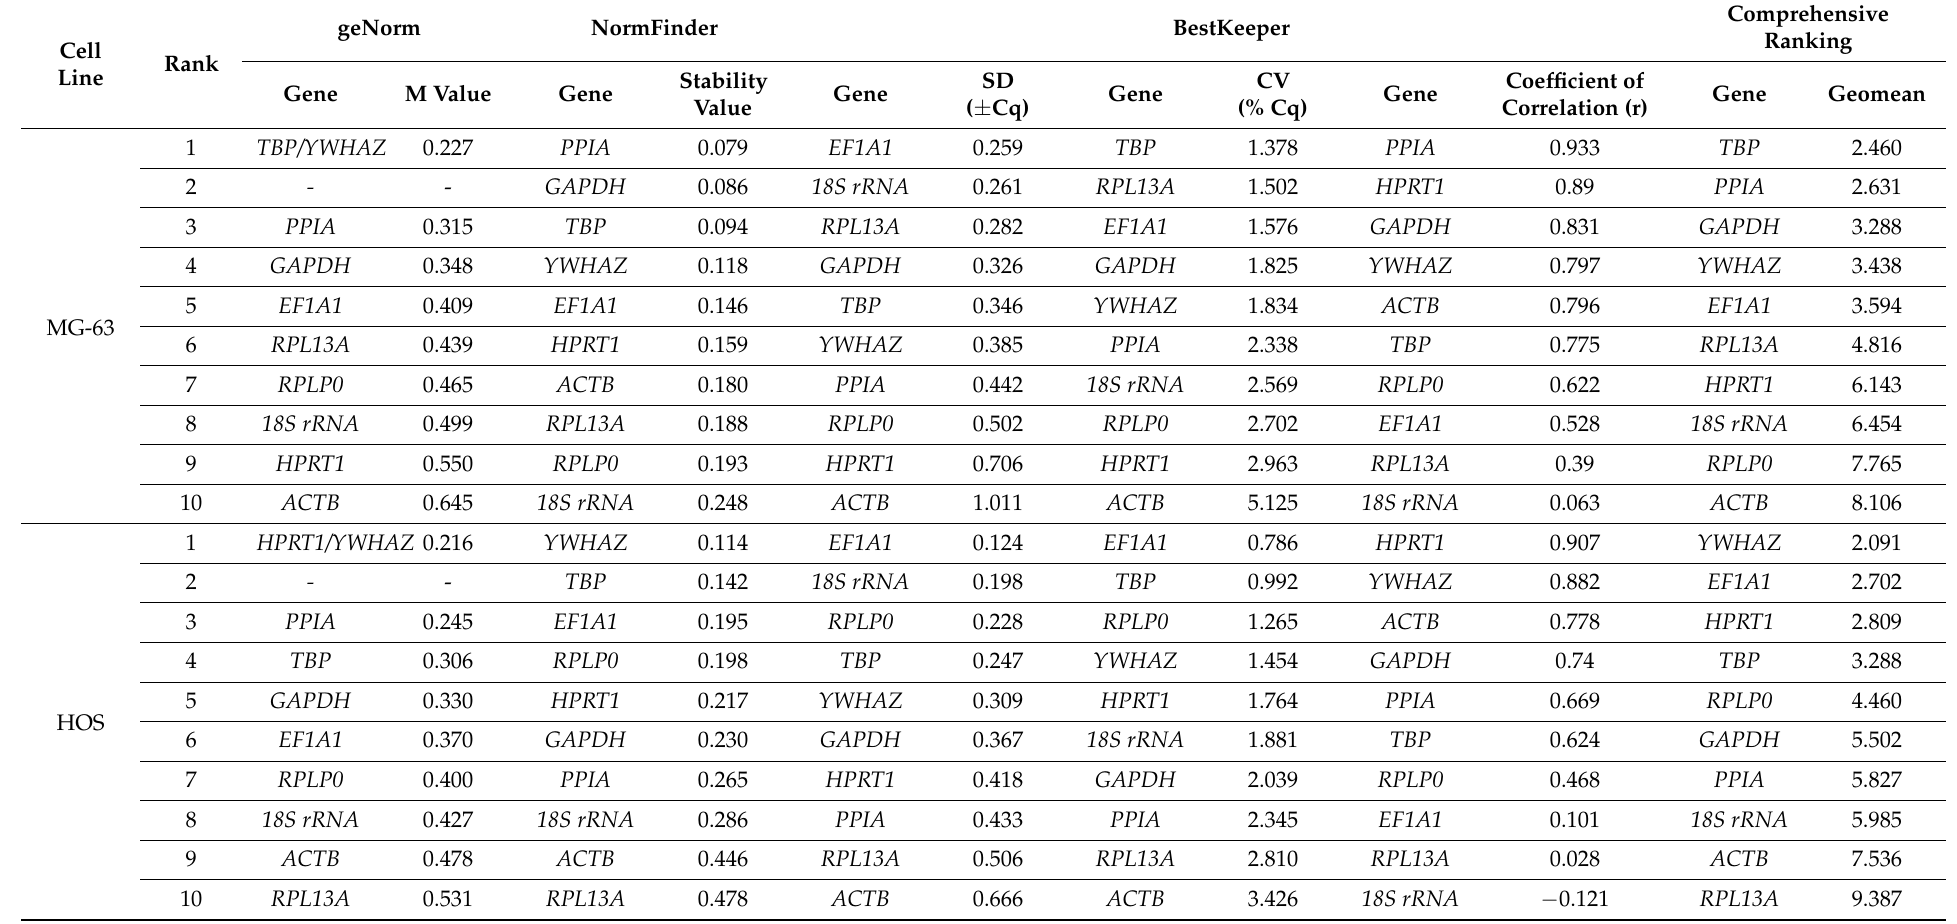
Table 3. Stability of selected candidate reference genes as ranked by geNorm, NormFinder, and BestKeeper in MG-63, HOS, and SaOS-2 cell lines. Candidates are listed from top to bottom by decreasing expression stability based on geNorm’s M value, NormFinder’s stability value, and BestKeeper’s SD, CD, and r as well as by geometrical mean of comprehensive